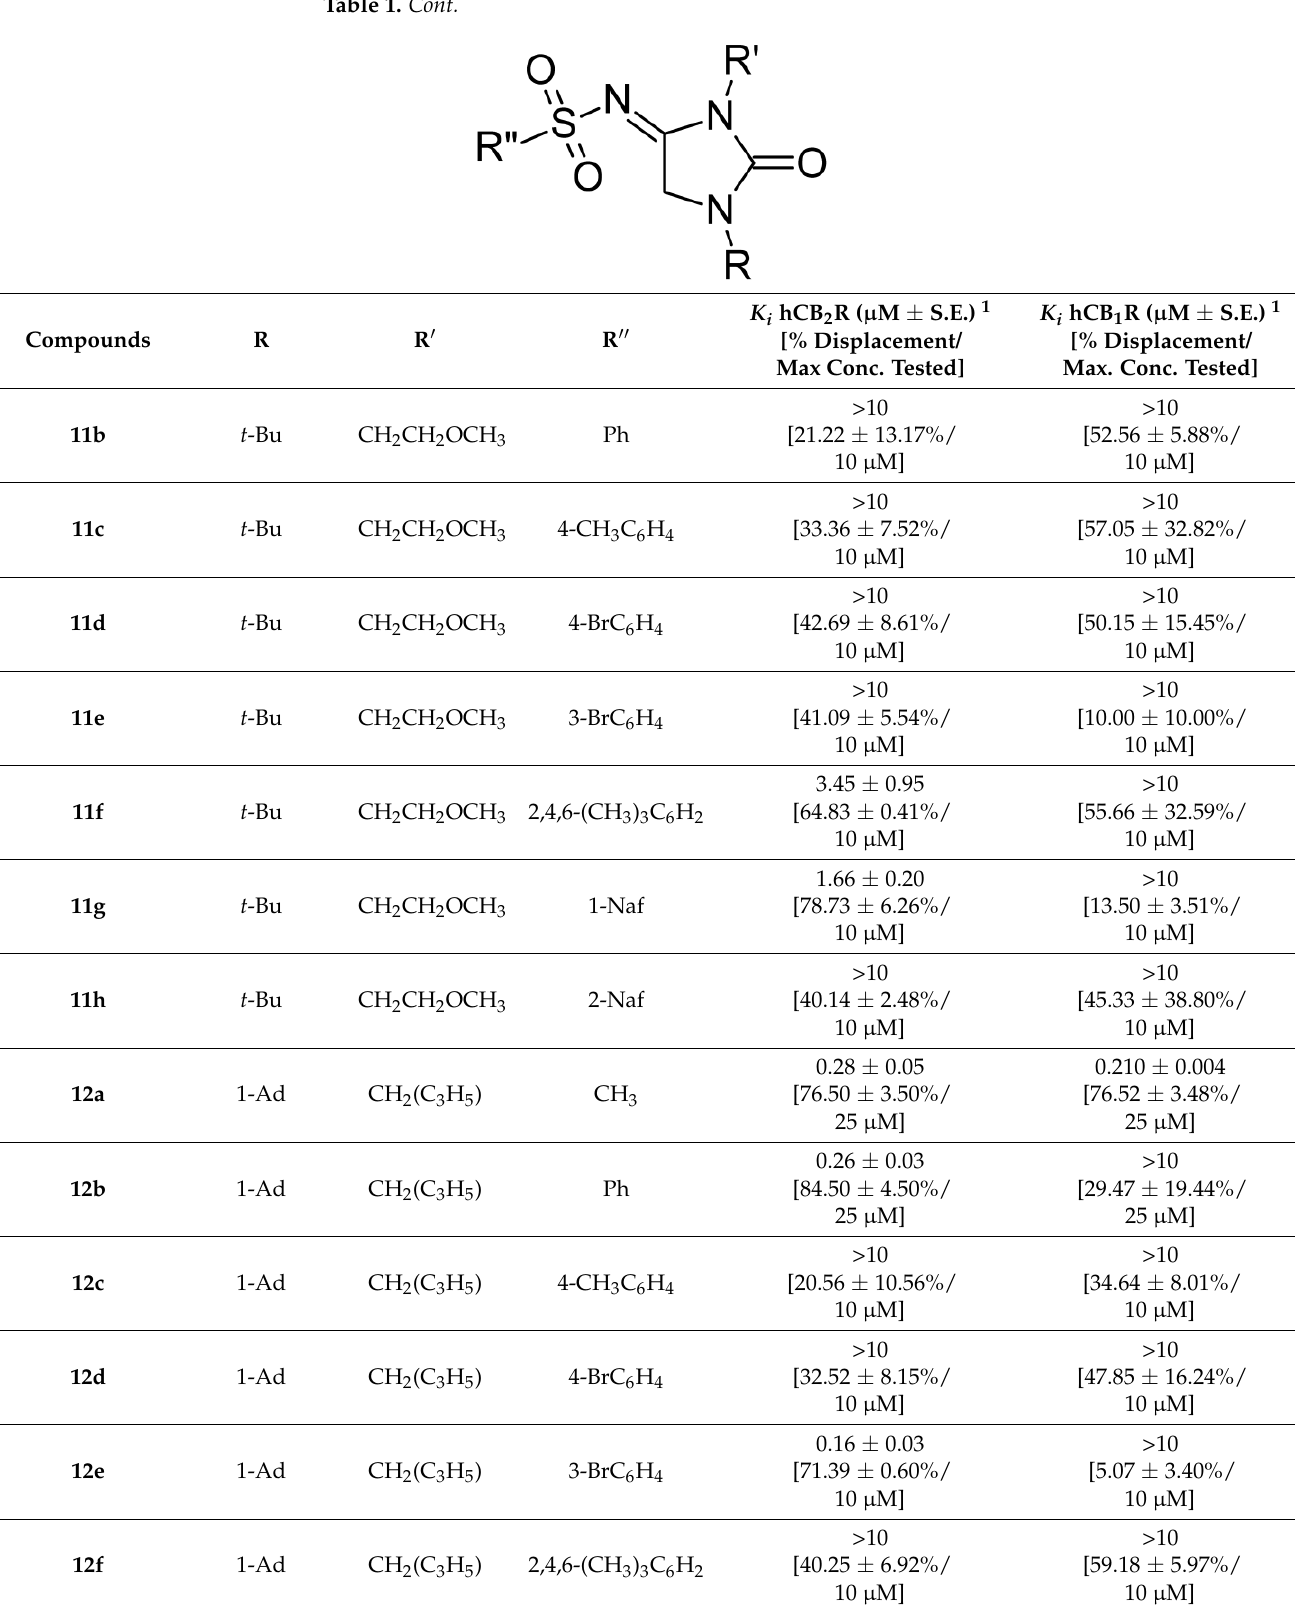
Table 1. Cont. Table 1. Affinity values for hCB1R and hCB2R of compounds of general